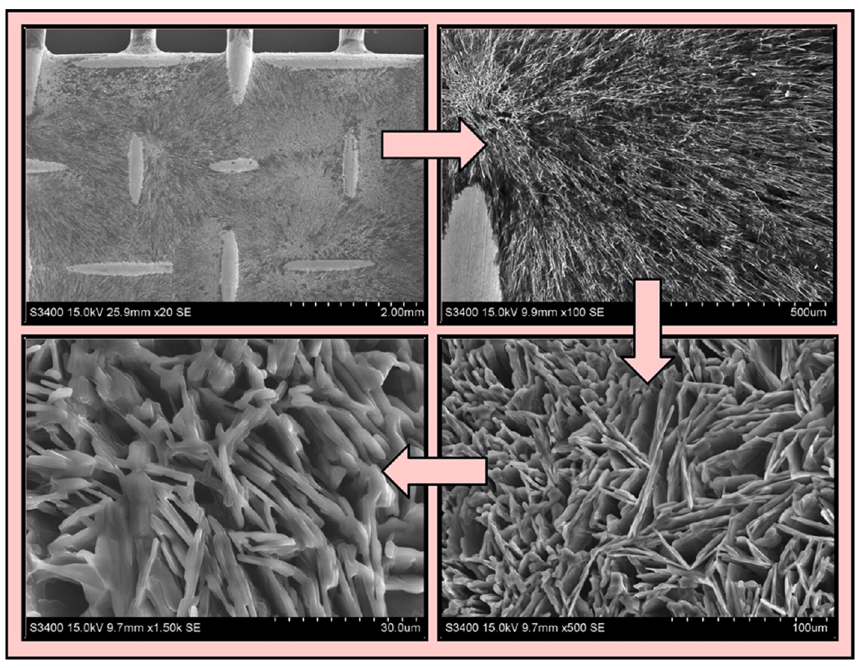
Figure 5. Scanning electron micrographs of the DES-3(1:3) sorbent deposited on the mesh.